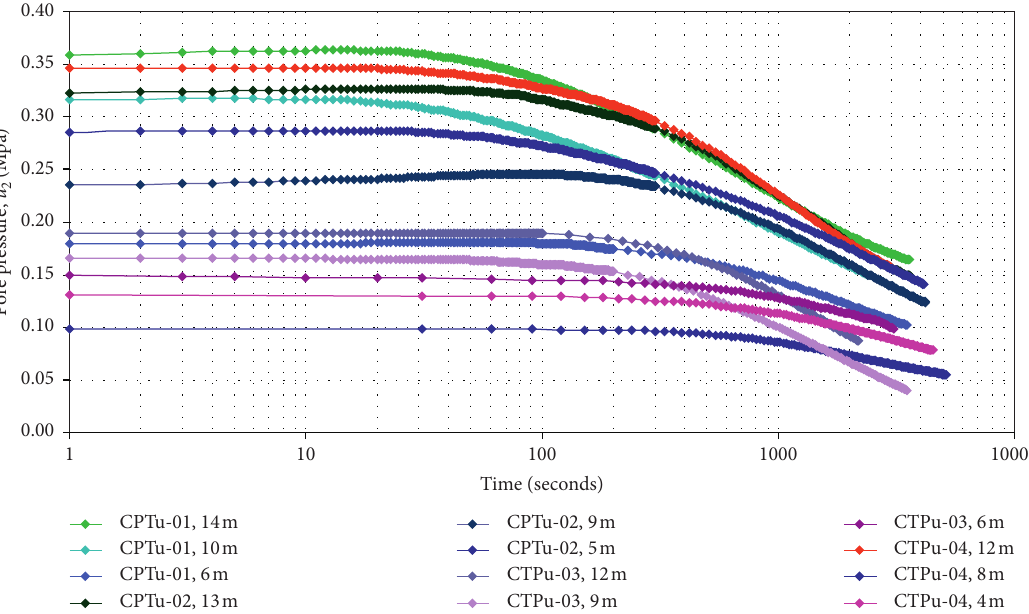
Figure 4: Dissipation curves with logarithm of time plot correction in Soc Trang province (Site 4). Table 1: The consolidation properties of soft soil at Site 4 determined by two